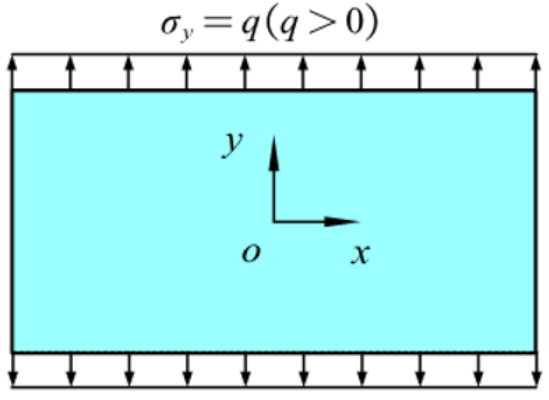
Figure 1. The rectangular plate subjected to uniform tension. The rectangular plate (excepting near the boundary) is uniformly discretized into a particle set with the equal spacing ∆ in the plane, as shown in Figure 2.